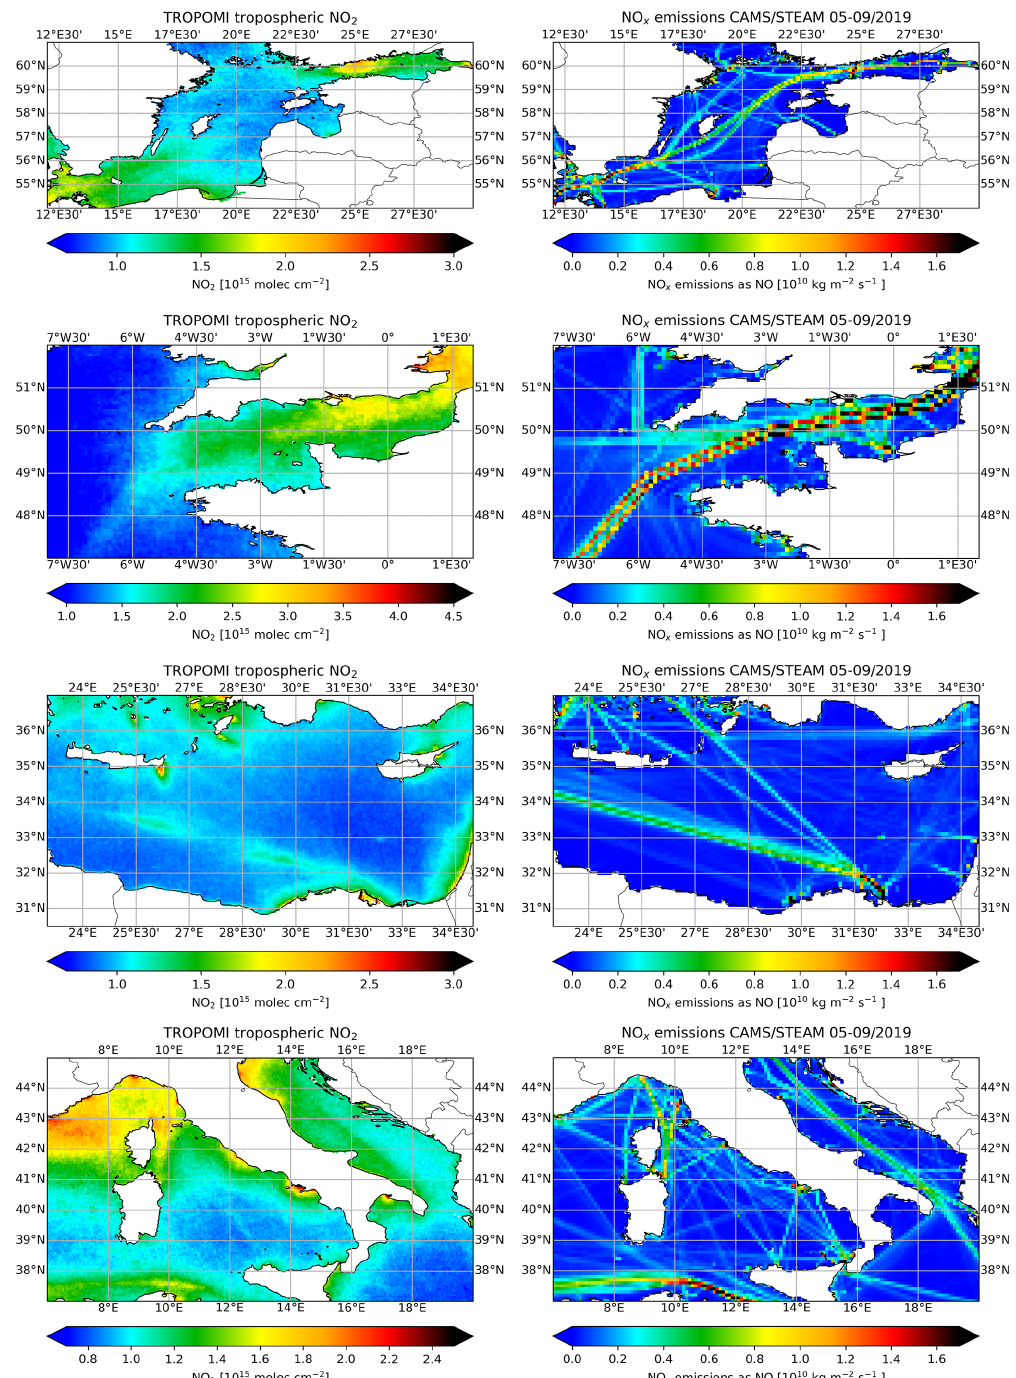
Figure A1. Summertime mean (May–September) tropospheric NO 2 columns from TROPOMI (left panels) and summertime mean NO x emissions from the CAMS/STEAM emission inventory (right panels; Granier et al., 2019; Johansson et al., 2017).